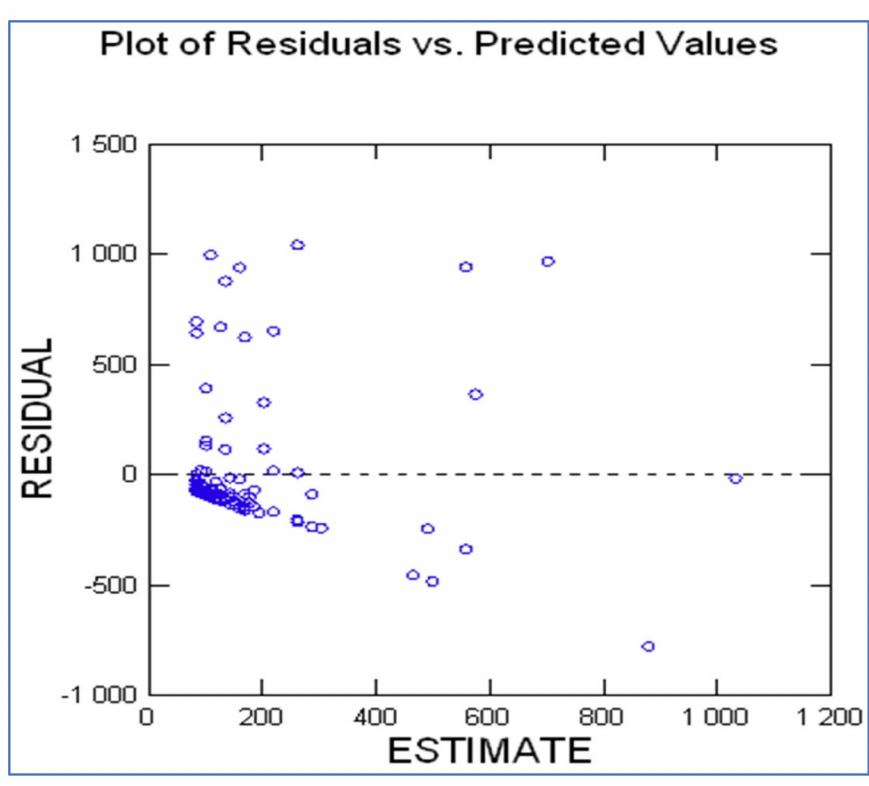
Figure 13. Plot of residuals vs. predicted